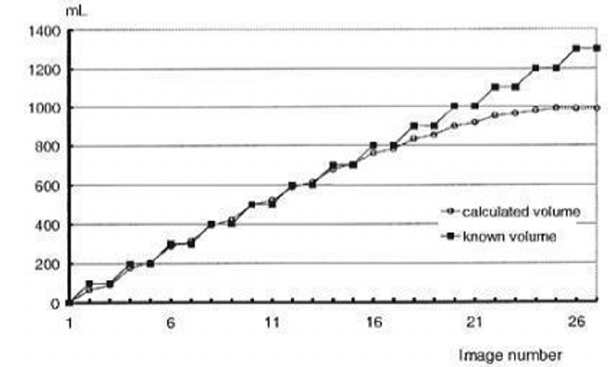
Figure 1 – Comparison between a known volume in the plastic bag and the calculated volume based on radioactivity measurements made by use of the gamma camera (Experiment A). For a volume of 50 mL, the observed aver- aged error was 17%, and the error was greater than 8% for volumes larger than 800 mL. For volumes between 100 mL and 900 mL, there was a significant correlation between the calculated volume and the known volume in the bag